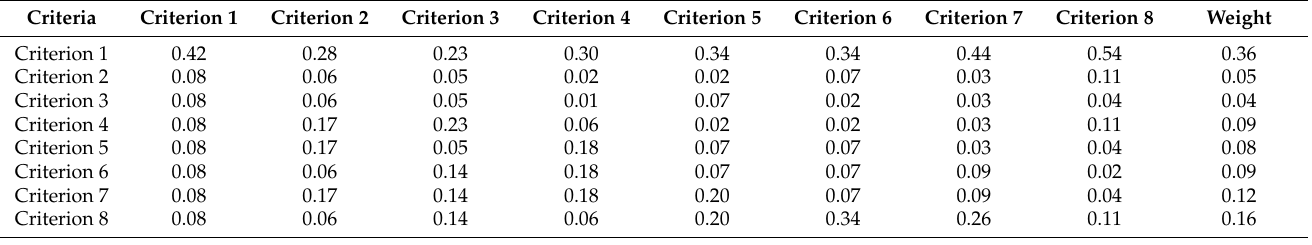
Table 3. Normalized matrix of the pairwise comparisons and the weights obtained for particular criteria (own study).